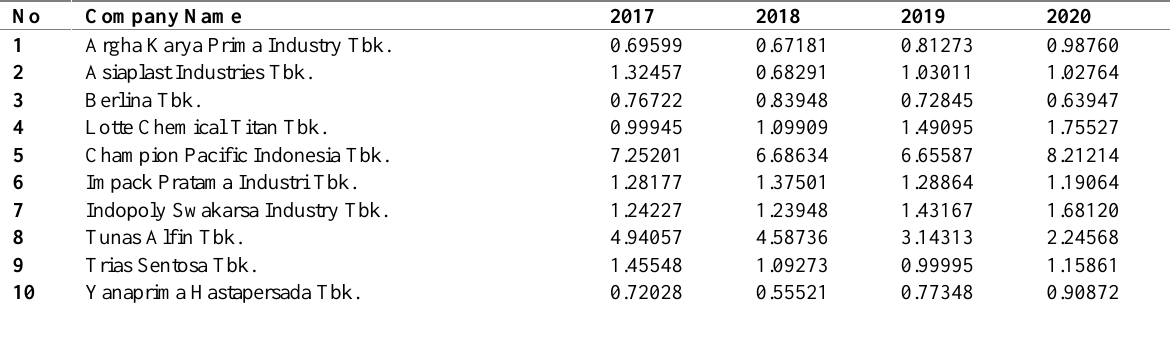
Table 4: Market Value of Equity to Book Value of Total